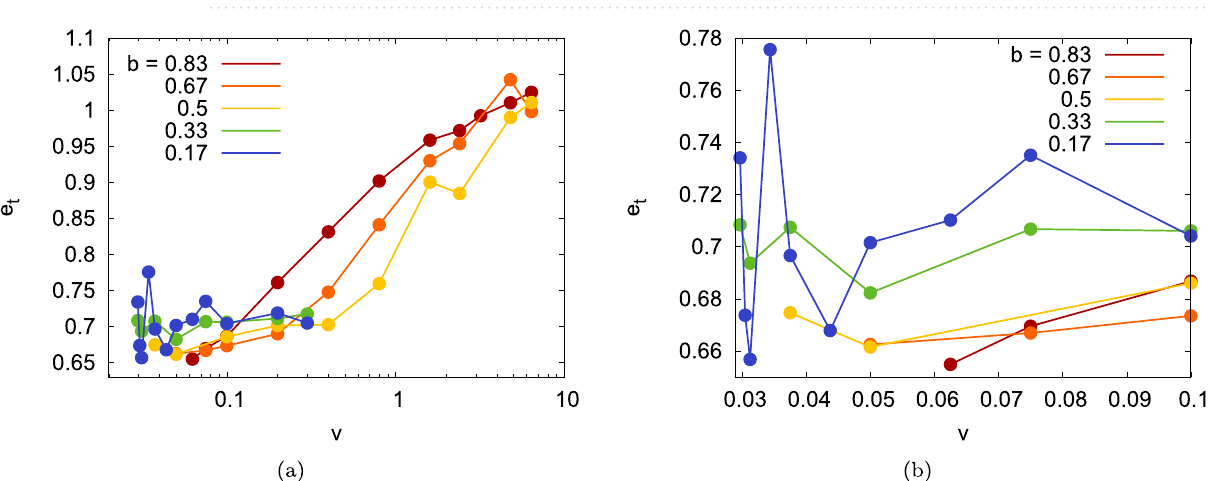
Figure 5. ( a ) Tangential restitution coefficient, e t , as a function of collision velocity v for several impact parameters b . (b) zooms into the low-velocity region. Data are only shown for bouncing collision. Note the logarithmic abscissa scale in subpanel ( a